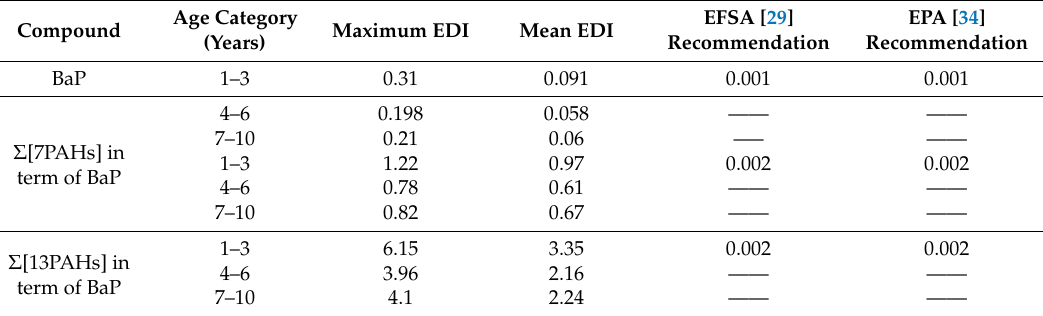
Table 6. Estimated Daily Intake (EDI) in terms of BaP (mg/day) for different age categories.